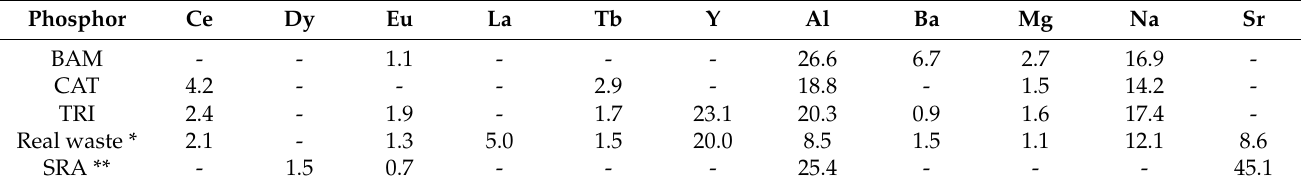
Table 1. Metal content (wt.%) of different phosphors.